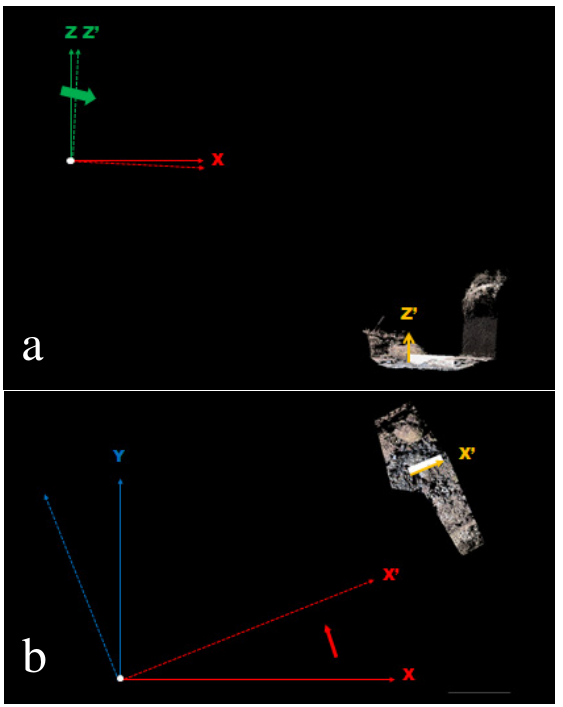
Figure 4. (a) Triangle created from surveyed points and a pole in Block 8, (b) a rectangular surface model.